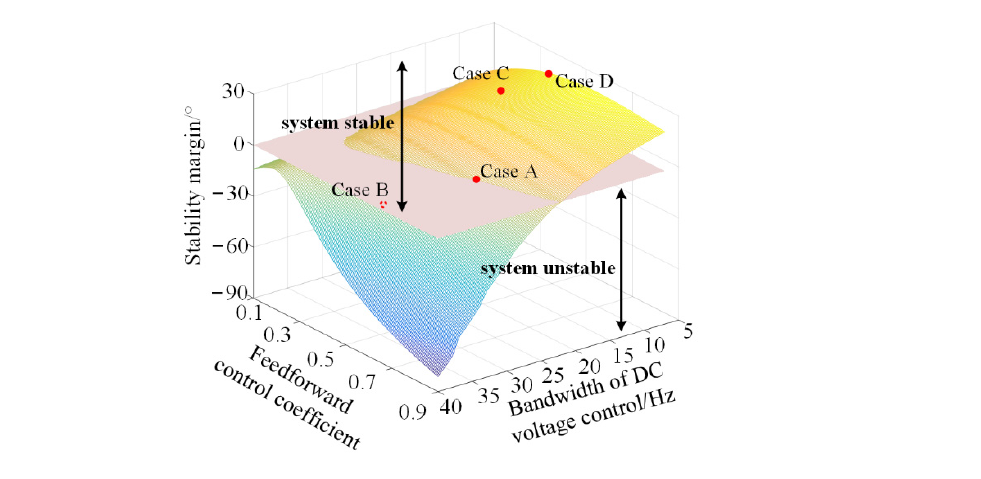
Figure 10. Impacts of voltage feedforward control coefficient and DC voltage controller bandwidth on stability margin of system.